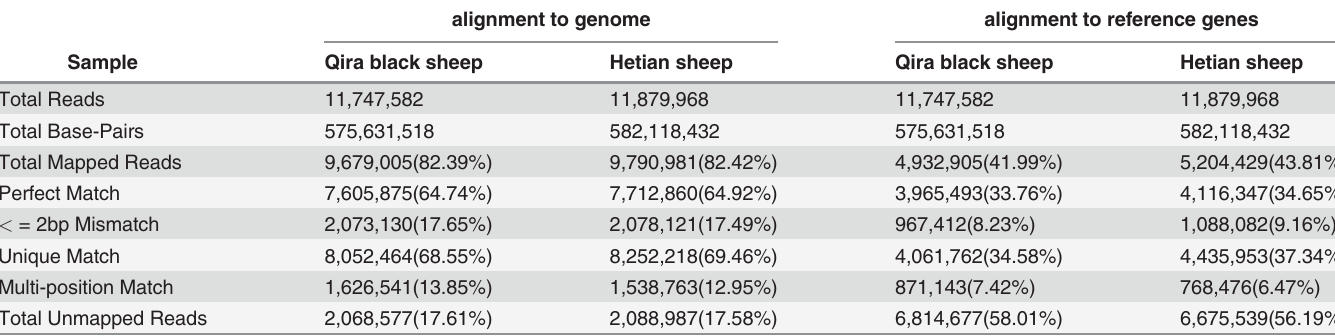
Table 1. A summary of the sequencing reads alignment to the Ovis aries genome and reference genes.